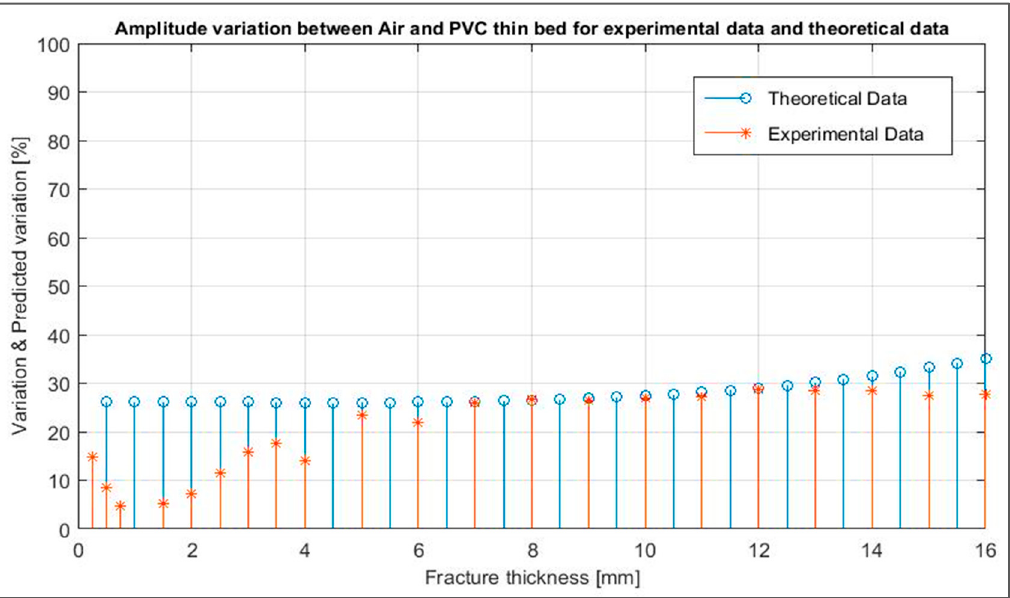
Figure 10. Comparing the amplitude difference between the air-filled and the PVC-filled fractures obtained from theoretical models (circles) and laboratory measurements (stars).